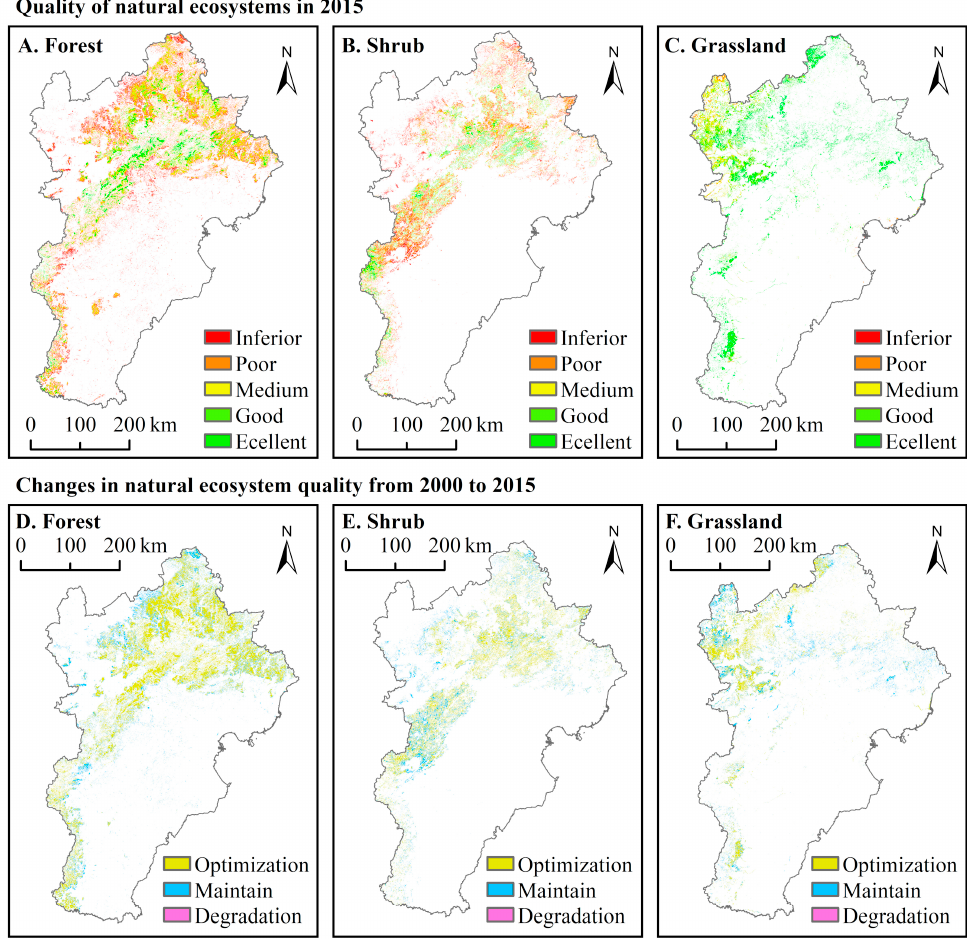
Figure 8. Distribution and changes in the quality of natural ecosystem assets in the Beijing–Tianjin– Hebei urban agglomeration from 2000 to 2015: ( A ) spatial distribution of forest ecosystem quality in 2015; ( B ) spatial distribution of shrub ecosystem quality in 2015; ( C ) spatial distribution of grassland ecosystem quality in 2015; ( D ) spatial distribution of forest ecosystem quality change from 2000 to 2015; ( E ) spatial distribution of shrub ecosystem quality change from 2000 to 2015; ( F ) spatial distribution of grassland ecosystem quality change from 2000 to 2015.